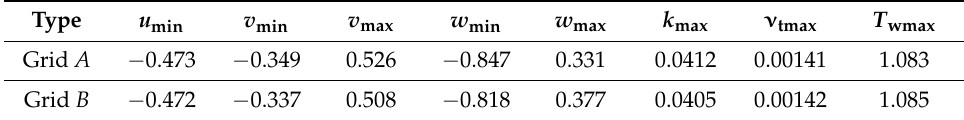
Table 4. VP2/3 code validation of the predictions of extreme flow, heat transfer and turbulence parameters for the narrow channel with the oval dimple of width b = 0.383.